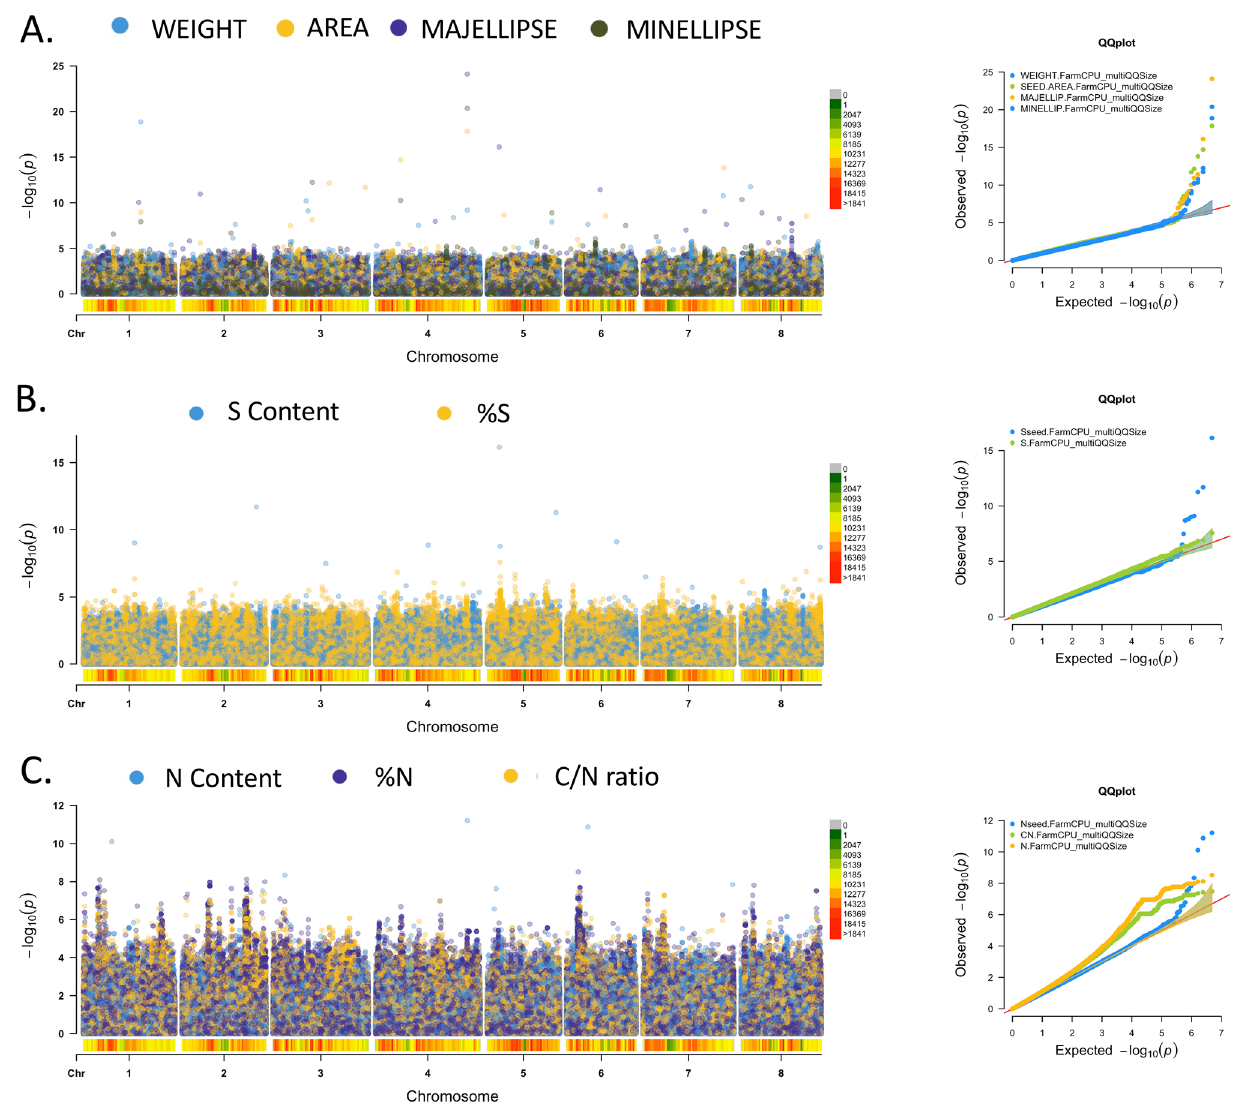
Figure 3. Genome-wide association studies of the Medicago seed traits with Manhattan plots and QQ plots obtained from FarmCPU. (A) Combination of association studies regarding seed size (weight, area, majellipse, minellipse). (B) Combination of association studies regarding seed sulfur content (mg/seed) and sulfur concentration (%, w/w). (C) Combination of association studies regarding seed protein content (nitrogen content (mg/seed); nitrogen concentration (%, w/w); carbon/nitrogen